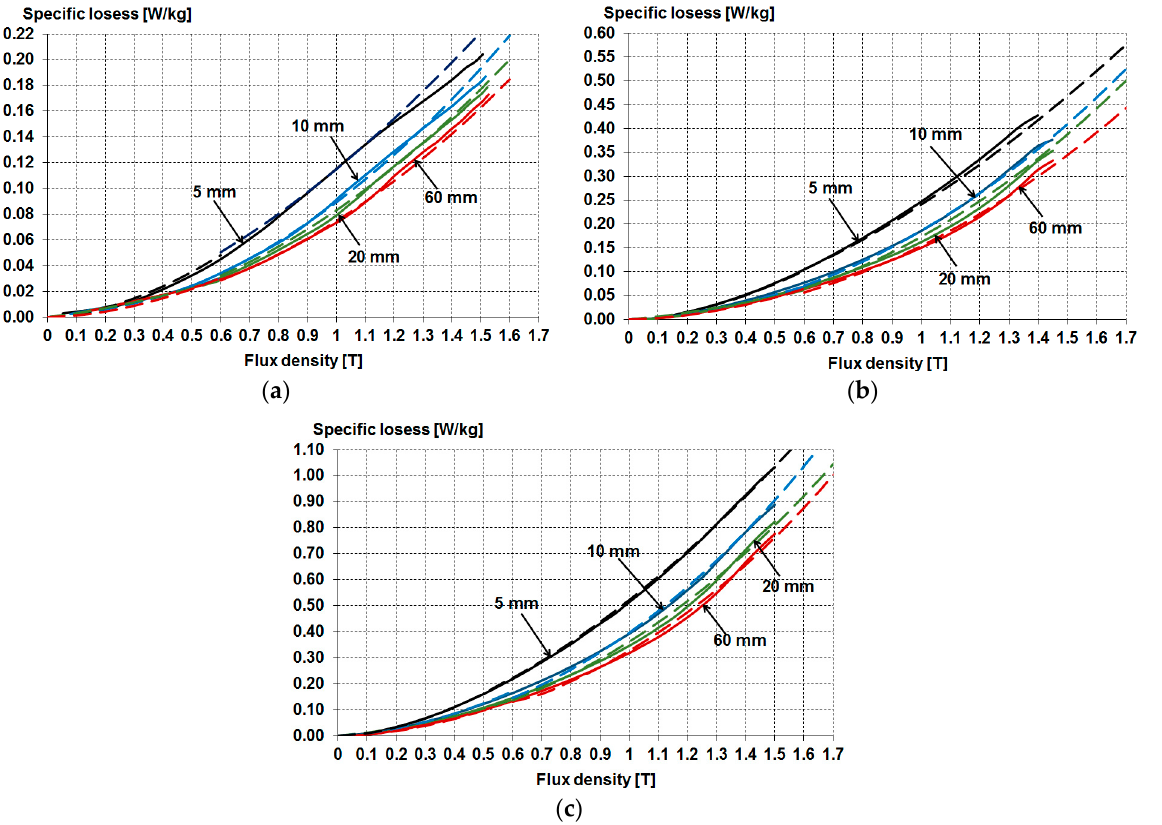
Figure 14. Measured and approximated loss characteristics of the M270-35A sheet for different widths of the sheet samples, at the frequency of 5 Hz ( a ), 10 Hz ( b ), and 20 Hz ( c ); (measured—solid line, estimated—dashed line).